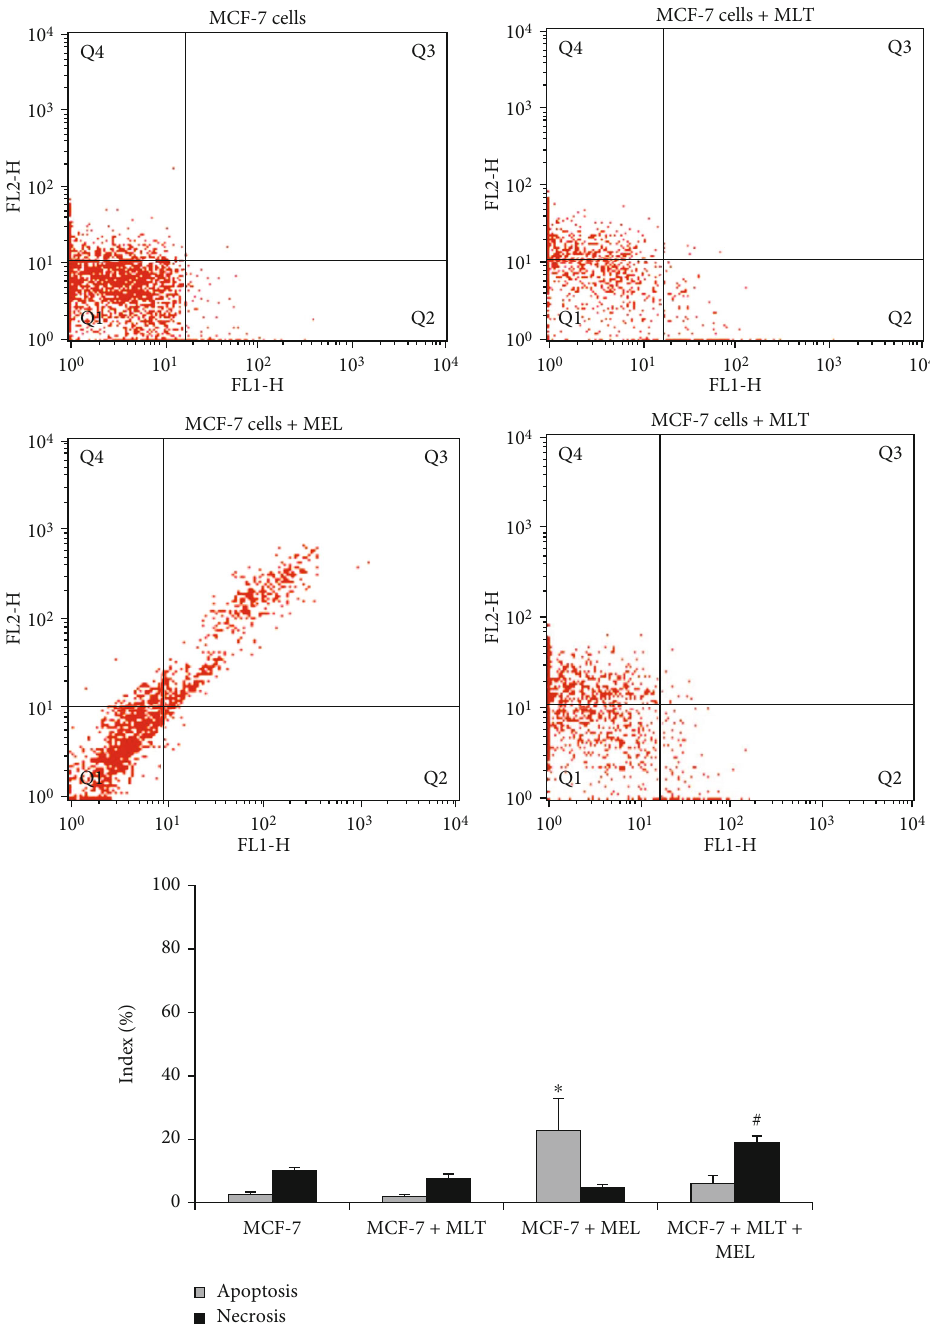
Figure 4: Apoptosis and necrosis indexes in MCF-7 cells. MCF-7: human breast cancer cells; MLT: melatonin; MEL: microemulsion after 72 hours of incubation. Cells were stained with Annexin V/PI and analyzed by fl ow cytometry. In the dot plot, the lower-left (Q1) quadrant corresponds to a viable cell; the lower-right (Q2) and upper-right (Q3) quadrants represent the percentage of apoptosis, and the upper-left (Q4) quadrant is the percentage of necrosis. p < 0 : 05 . ∗ Compared to apoptosis index of PMNs untreated with PMNs treated; # compared to necrosis index of PMNs treated with